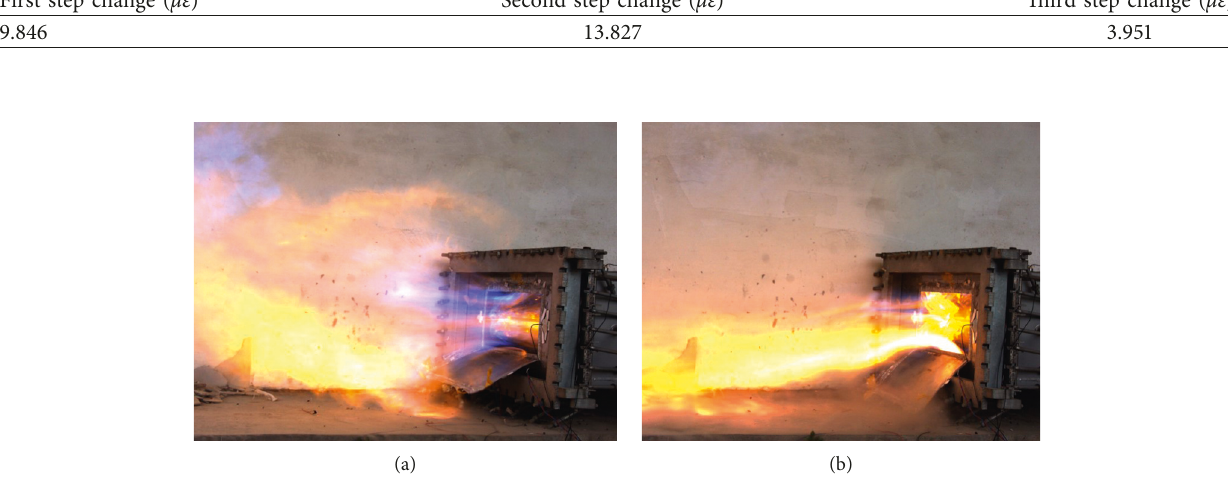
Figure 24: Flame group formed near the explosion vent in the third test.